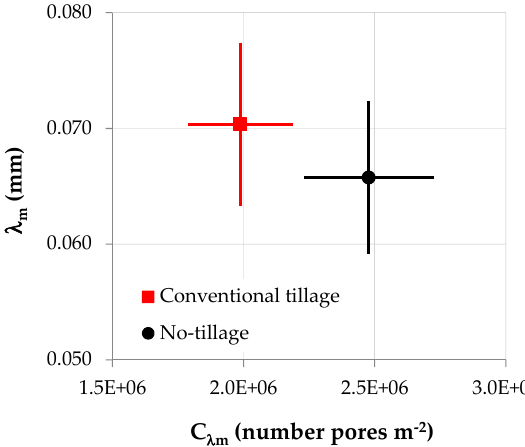
Figure 5. Comparison between of CT and NT in terms of mean values of flow-weighted mean pore size, λ m , and number of hydraulically active pores per unit area, C λ m (i.e., Gravina + Candela dataset). Bars represent ± 10% deviation on the mean values.